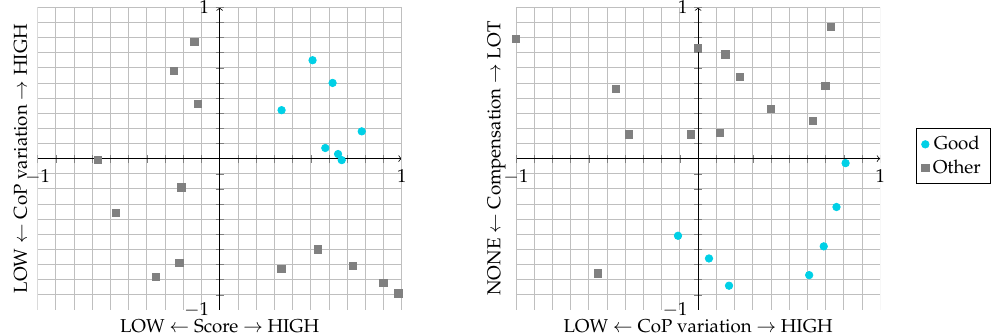
Figure 11. Plot of Score–CoP variation and CoP variation–Compensation features in HotAir game. Data were labelled as “Good” or “Other” by the therapist according to patients’